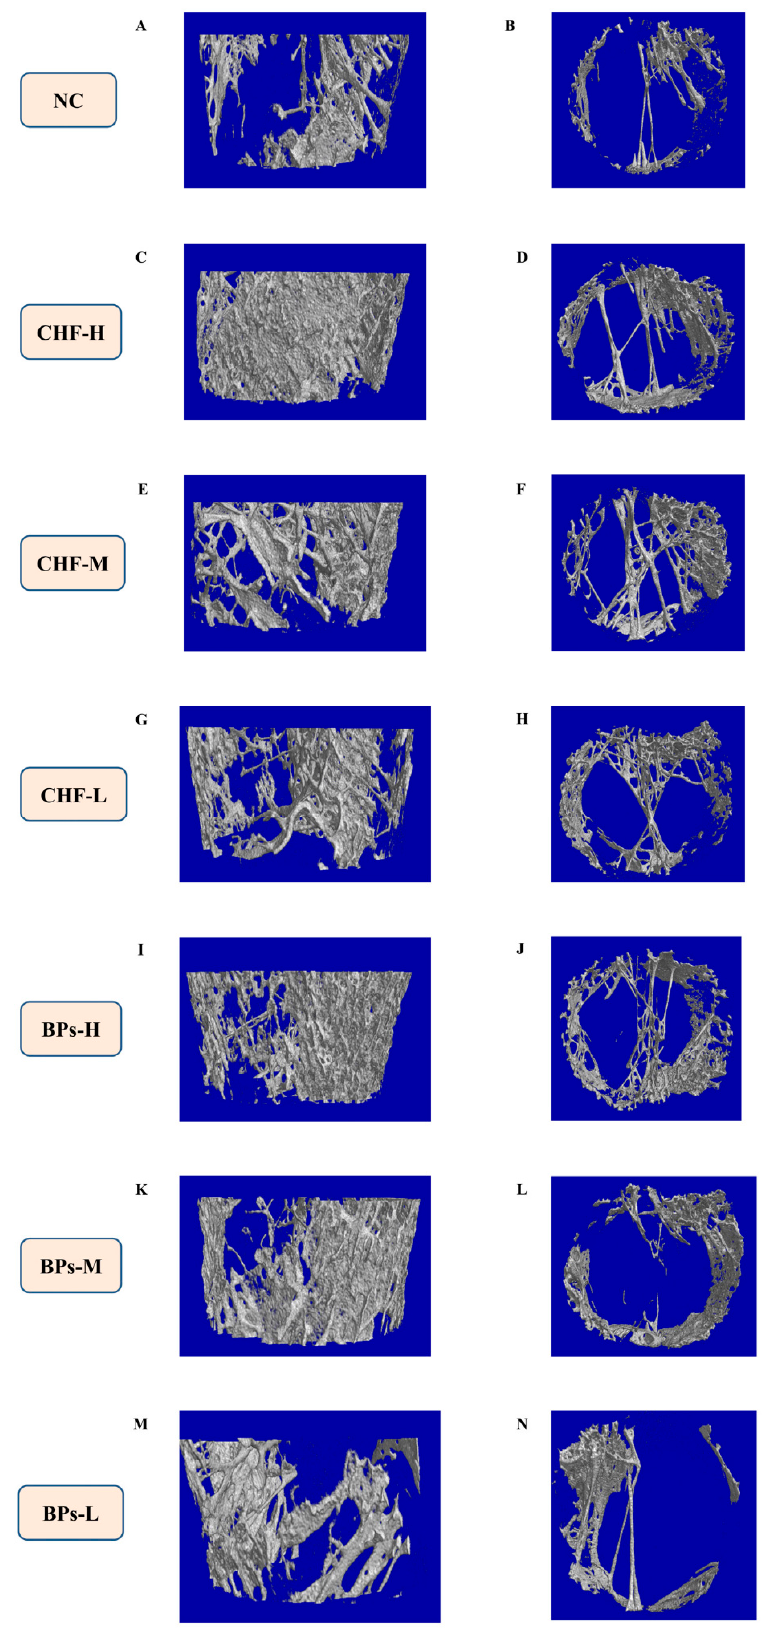
Figure 2. 3D structure of cancellous bone of distal femur at 60 days of age. ( A ) Longitudinal